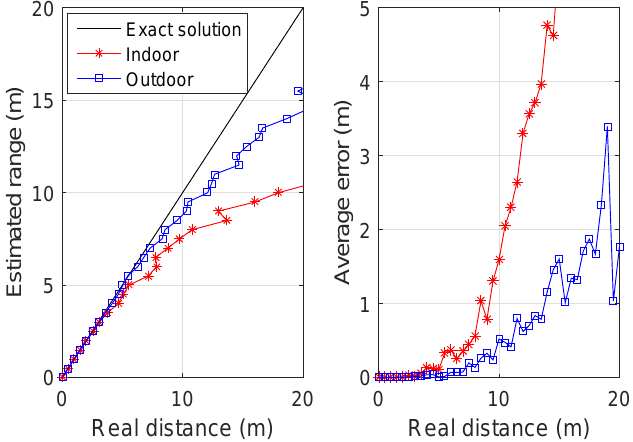
Figure 3. An example of the quantized RSS scheme when S =